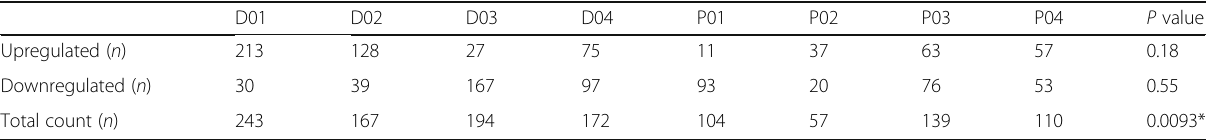
Fig. 1 Plasma miRNA levels in patients with polymyositis/dermatomyositis before and after treatment. Plasma samples of patients with polymyositis (P) and dermatomyositis (D) were taken before and after treatment and analyzed by miRNA microarray; differentially expressed miRNAs were selected based on at least twofold change between paired samples taken before and after therapy, and a heat map was constructed using log 2 fold change values (blue, the lowest, and red, the highest). miRNAs are indicated on the left; D01 – D04: DM patients; P01 – P04: PM patients Results miRNA levels in plasma of PM/DM patients before and after treatment Analysis of circulating extracellular miRNA in patients with myositis revealed differences in miRNA plasma levels be- tween DM and PM patients and showed that treatment sig- nificantly affected miRNA expression in plasma (Fig. 1). The numbers of differentially expressed miRNAs with at least twofold change caused by treatment indicated that there were significantly more miRNAs whose plasma levels were affected by treatment in DM compared to PM ( P = 0.0093) (Table 2). The average numbers of miRNAs differentially expressed in plasma of DM and PM patients before and Table 2 Numbers of differentially expressed (twofold change) miRNAs in PM and DM